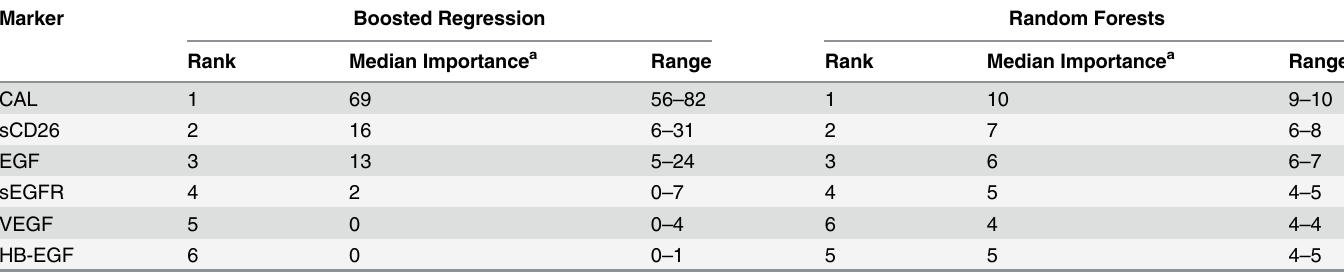
Table 4. Ranking of each marker according to its importance for predicting Lung